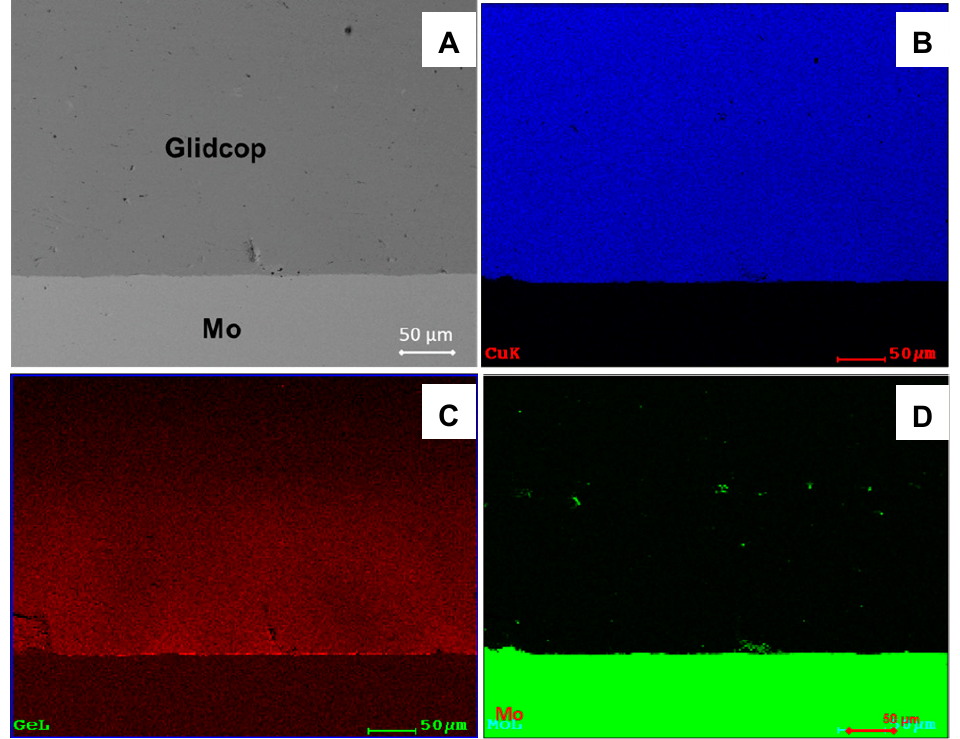
Figure 8. ( A )SEM cross-section of an 18-µm thick Cu plated Glidcop/Mo joint; ( B ) Cu EDS mapping;